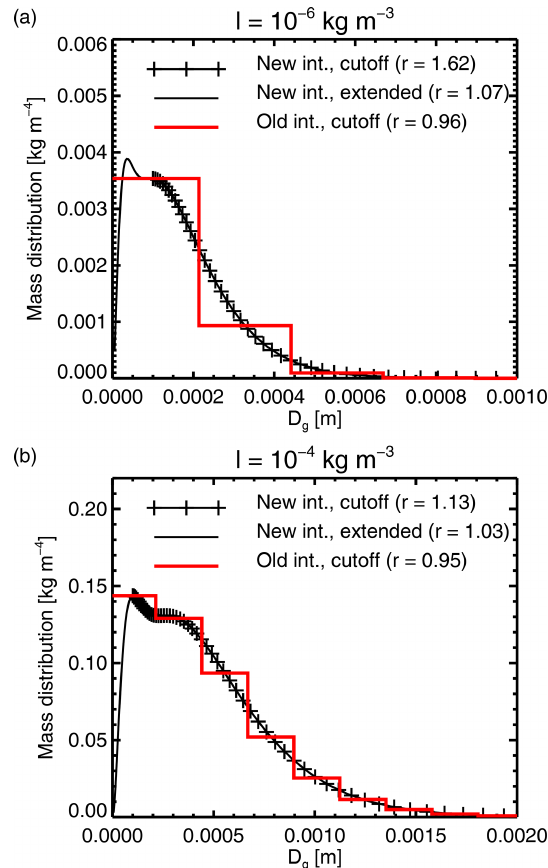
Figure 5. Numerical integration options illustrated using the recon- struction of the implied water content (Eq. 16), for the F07 T PSD with the ARTS large plate aggregate and T = 223K. The mass dis- tribution is a(D g ) b n g (D g ) , using the PSD before renormalisation. The specified water content is (a) l = 1 × 10 − 6 kgm − 3 and (b) l = 1 × 10 − 4 kgm − 3 . The resulting renormalisation factor ( r ; see Sect. 3.2.2) is indicated in the legend. The integration options are the new integration with D min = 1 × 10 − 4 m (100µm) cutoff (black crosses), the new integration extended down to D g = 5 × 10 − 6 m (black line), or the old integration (red